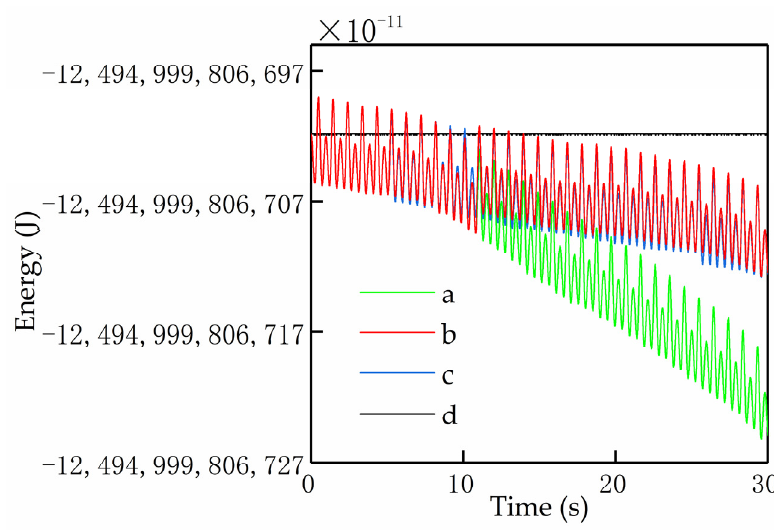
Figure 8. Variation of the mechanical energy for the planar four bar mechanism.